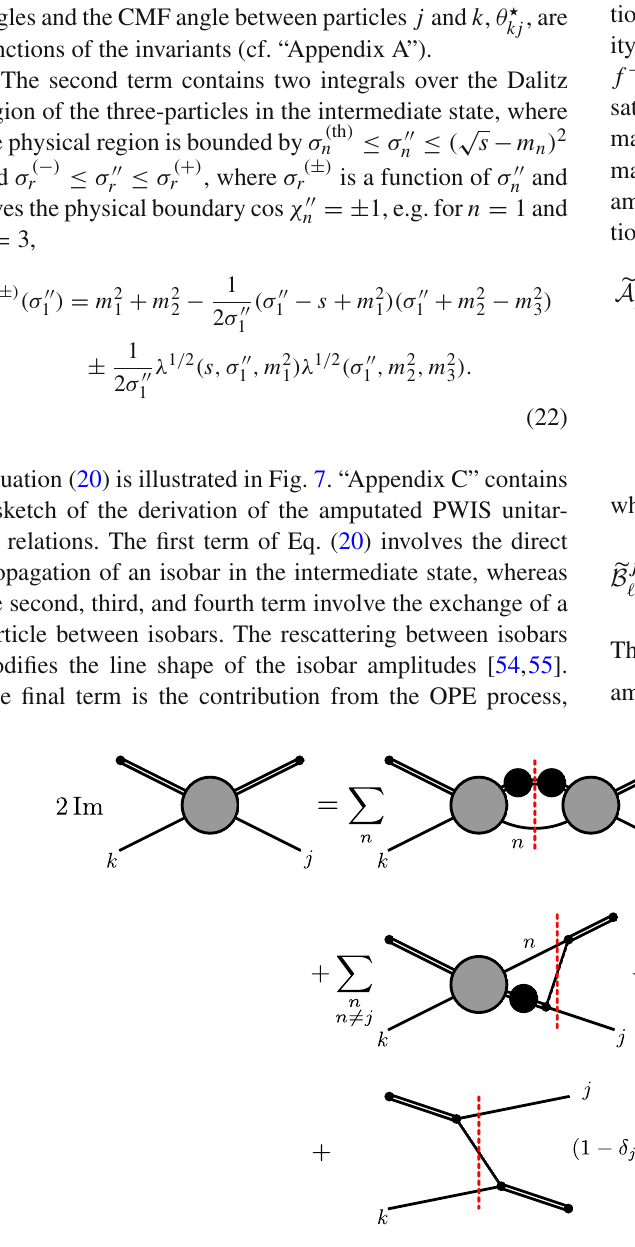
Fig. 7 Diagrammatic representation for the amputated PWIS unitarity relation in Eq. (20). The black disks in the internal legs represent the isobars, which are amputated from the external legs, see Eq. (19). The cuts across the OPE in the intermediate states yield recoupling